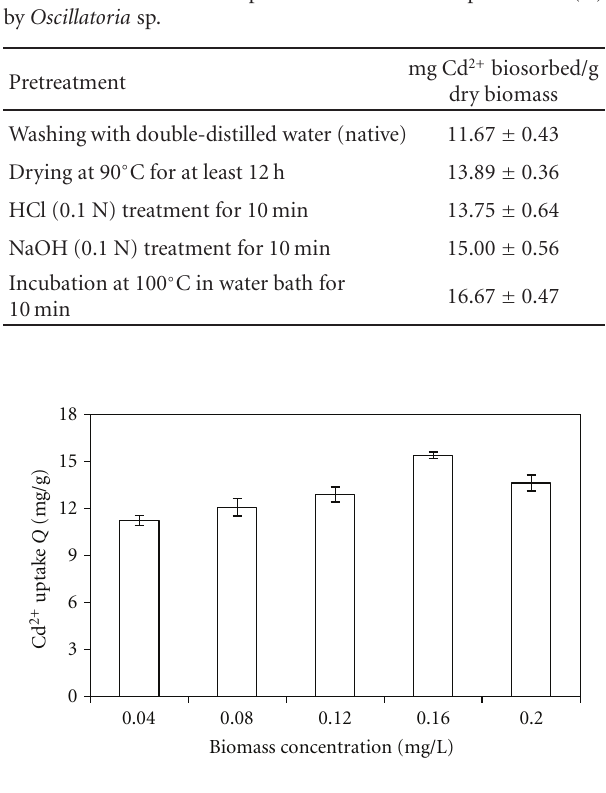
Figure 4: Biomass concentration-dependency profile of Cd(II) up- takes by dried biomass at initial concentration of 10ppm; tempera- ture 25 ◦ C; pH